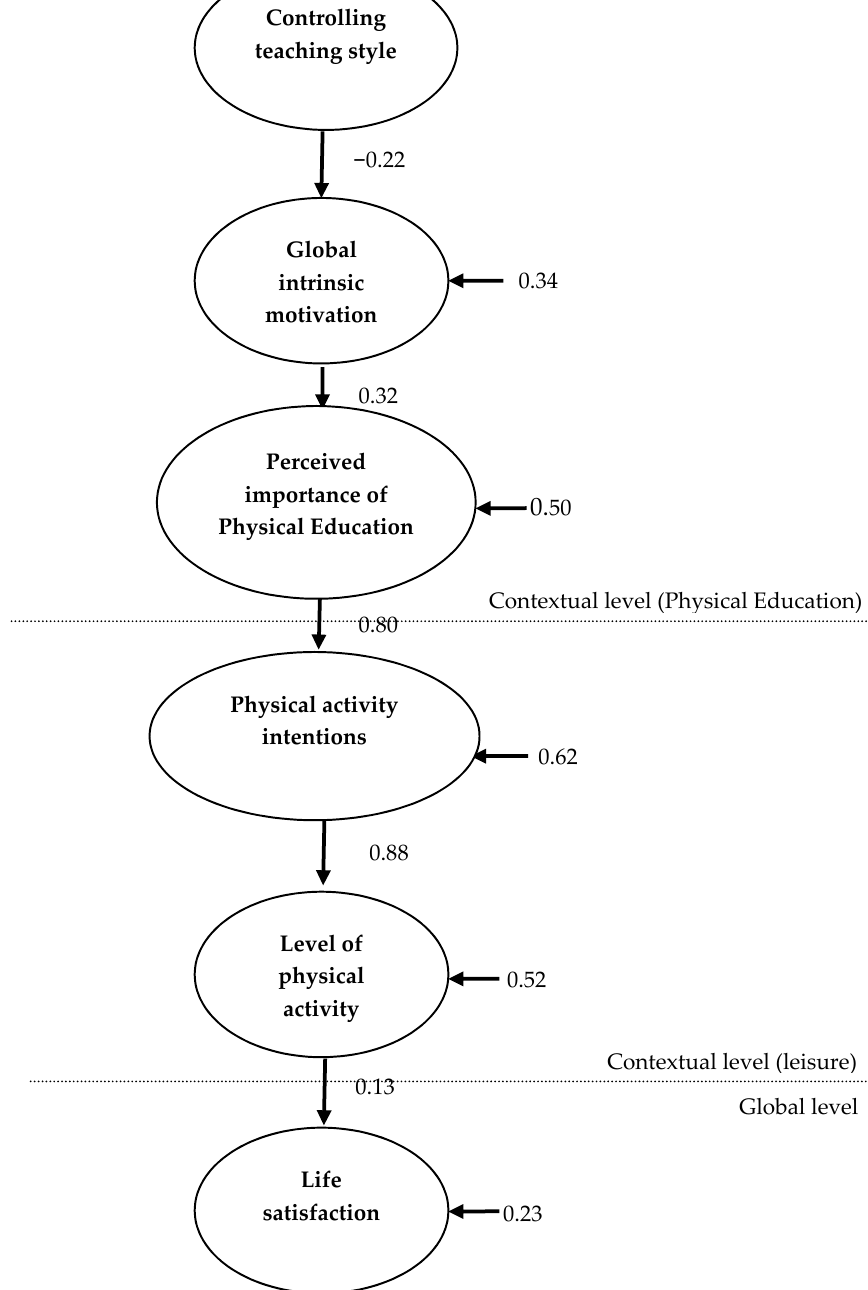
Figure 1. Structural regression model. The parameters are standardized and significant, p < 0.05.